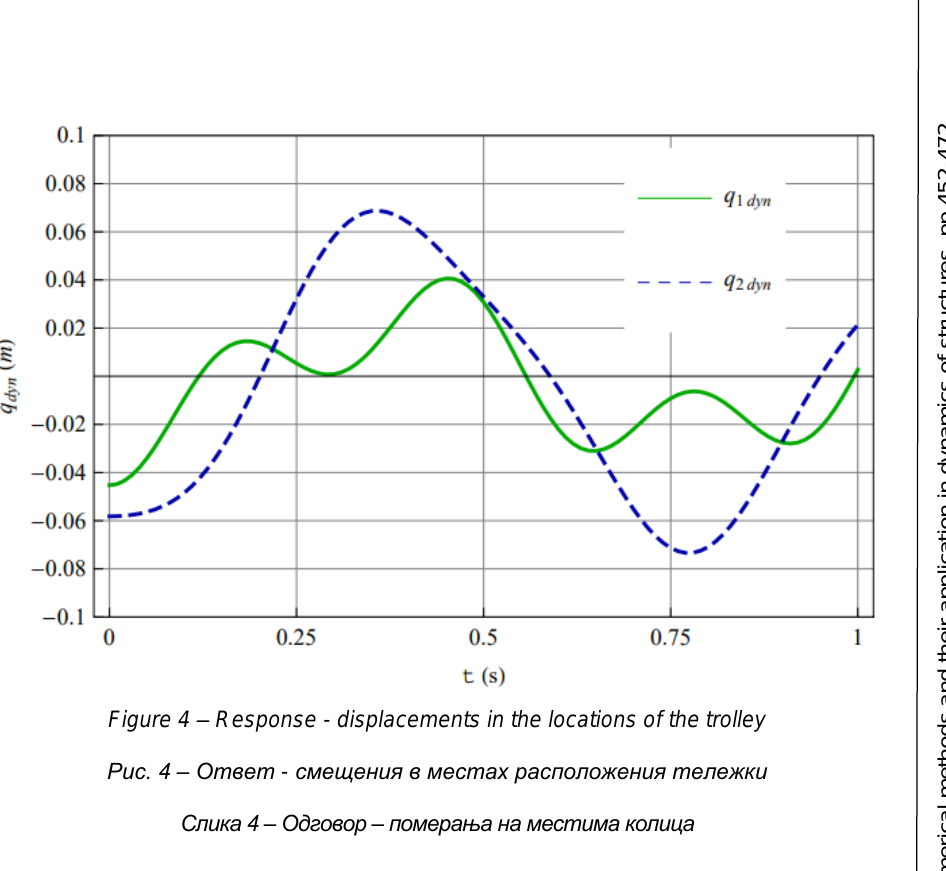
Figure 4 – Response - displacements in the locations of the trolley Рис. 4 – Ответ - смещения в местах расположения тележки Слика 4 – Одговор – померања на местима